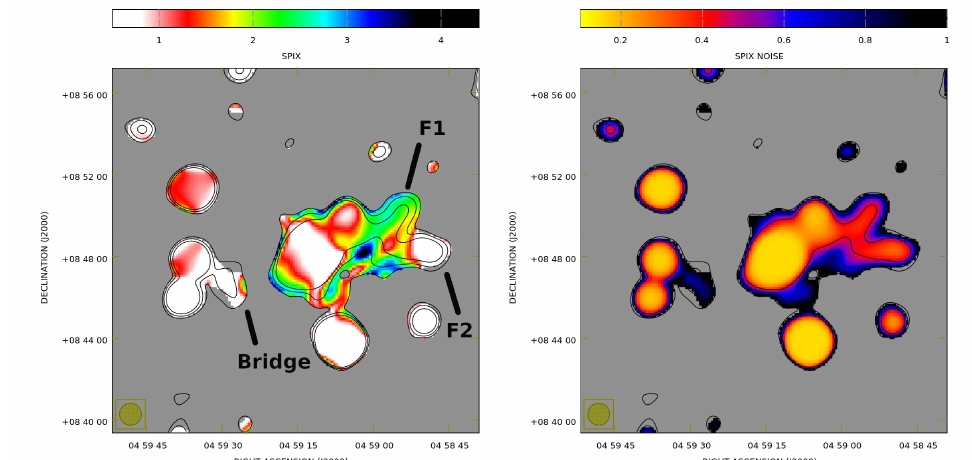
Figure 2. Spectral index (left panel) and spectral index uncertainty (right panel) between 1.410 and 1.782GHz at 65 (cid:48)(cid:48) . Black contours have been drawn at 0.5, 0.8 and 1.3mJy/beam of the radio emission at 1.782GHz. The synthesized beam is shown in the bottom left corner.